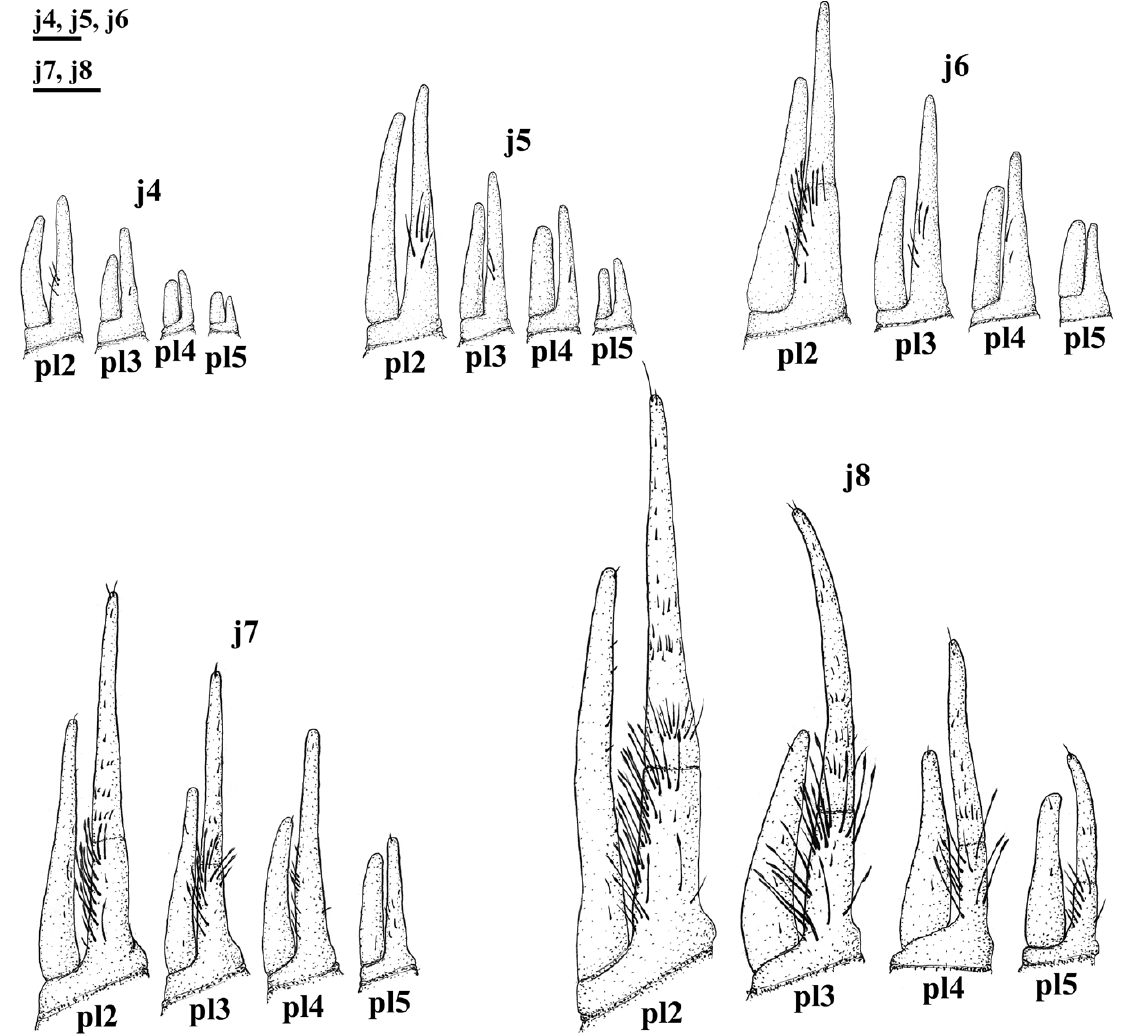
Figure 8 - Callinectes danae . pl2 to pl5: pleopods from the 2 nd to 5 th female abdominal somites, respectively, from 4 th (j4), 5 th (j5), 6 th (j6), 7 th (j7) and 8 th (j8) stages on. Scale: j4, j5 and j6, 0.1mm; j7 and j8,